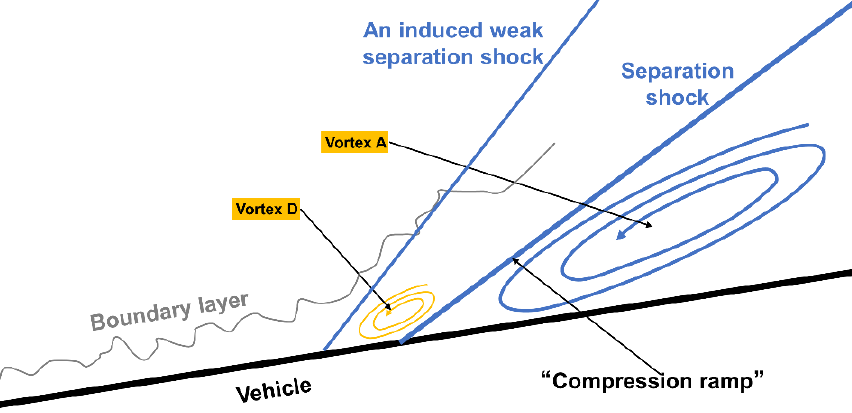
Figure 27. Schematic diagram of the generation mechanism of the D-type vortex.